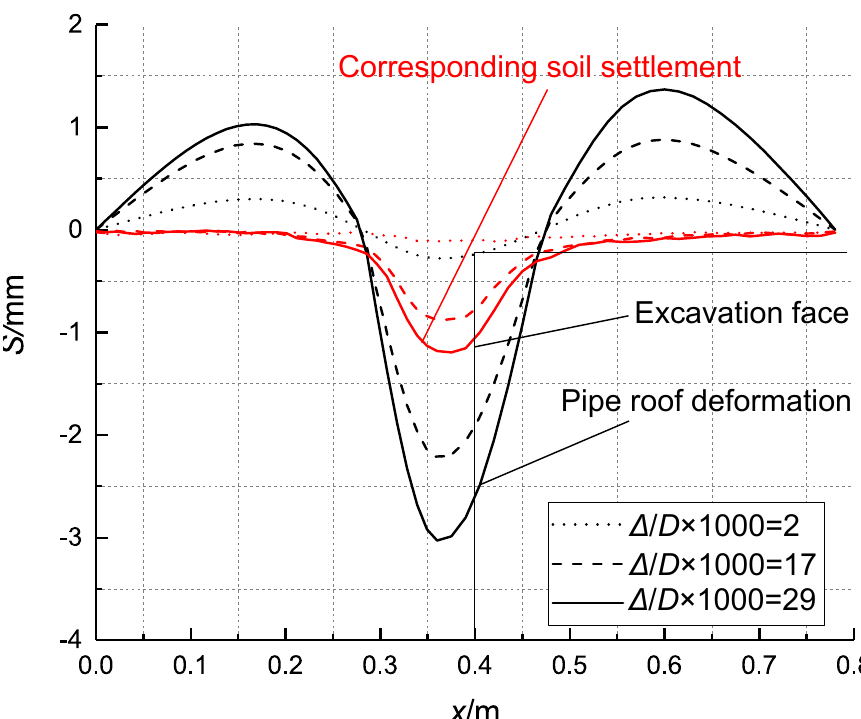
Figure 15. Pipe roof deformation and corresponding soil settlement at different stages ( EI = 1.0, C / D =